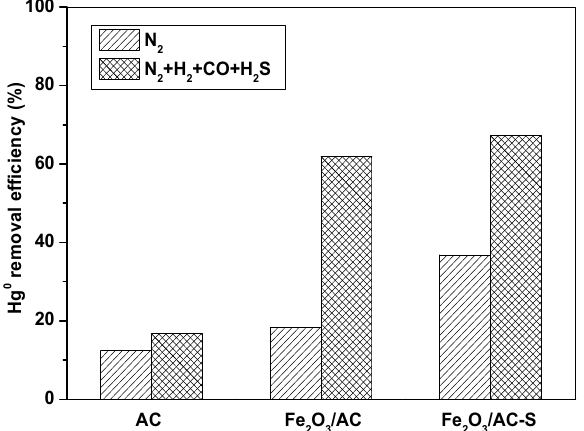
Figure 7. Comparison of Hg 0 removal by AC, Fe 2 O 3 /AC, and Fe 2 O 3 /AC-S. (Reaction condition: 10% H 2 , 15% CO, 1500 ppm H 2 S, balance N 2 , C Hg0 = 80 μ g/m 3 , GHSV = 15000 h − 1 , T = 150 °C.)